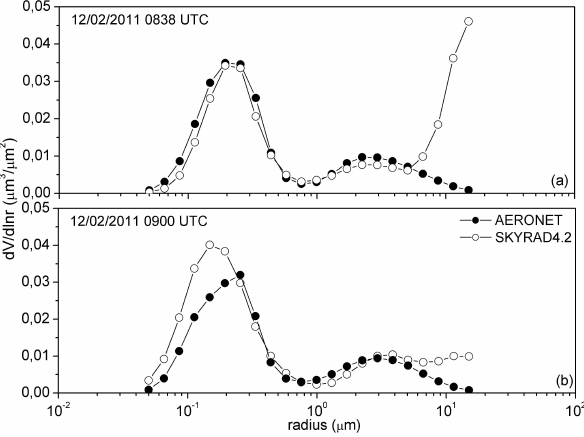
Fig. 4. Two representative cases of type II SKYRAD solutions with a second coarse mode that leaves the distributions tails